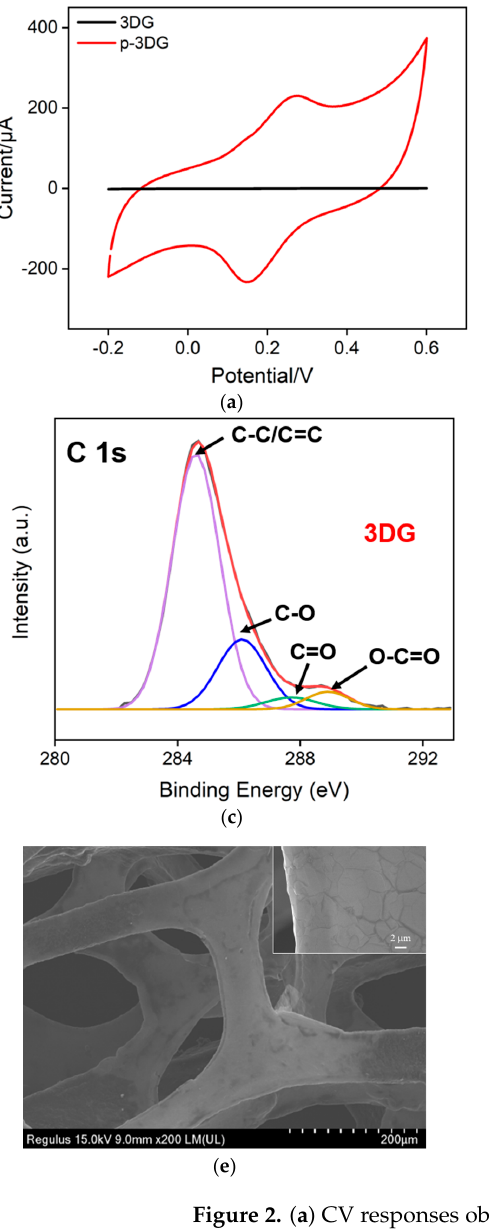
( b ) Figure 3. CV curves obtained on different electrodes in 0.05 M KHP solution (pH = 4) containing 0.5 mM Fe(CN) 63 − ( a ) or 0.5 mM Ru(NH 3 ) 63+ ( b ). Transmission electron microscopy (TEM) was employed to study the morphology of VMSF. Figure 4a shows the top-view TEM of VMSF at different magnifications. It can be seen that the film is flat and crack-free in the submicron range, and a regular arrangement